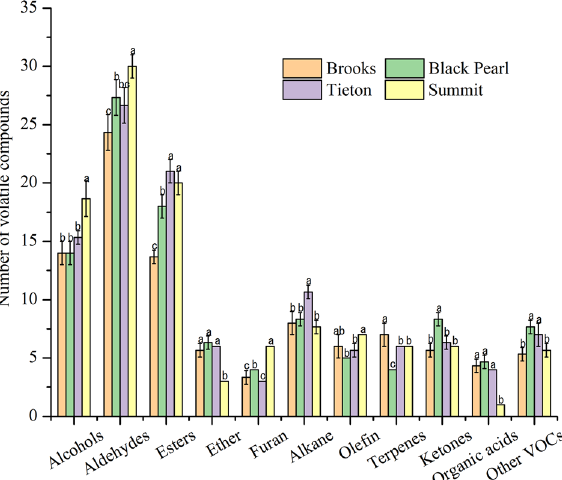
Figure 5. Number of volatile organic compounds of sweet cherry flower essential oils. The vertical bars represent the standard deviation of the means (n = 3). Different letters (for the same compound) indicate significant differences (p < 0.05).